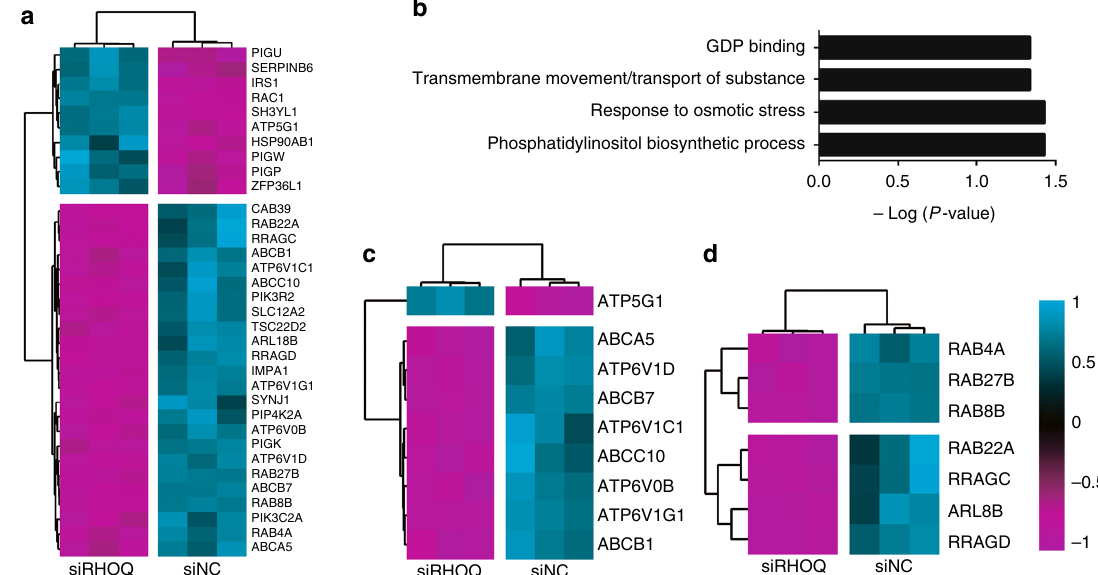
Fig. 4 RHOQ knockdown suppressed Rab GTPase and ATP-mediated membrane transporter system. HCT-116 were transfected with NC or RHOQ siRNAs for 36 h, and then RNA was collected and analyzed by GeneChip Human Genome U133 Plus 2.0 Array (Affymetrix). Microarray analysis was performed on three biological samples. a Heat maps of the gene expressions after RHOQ knockdown; b GO analysis of genes in F; c heat maps of the V-ATPase family; d heat maps of the GDP-binding